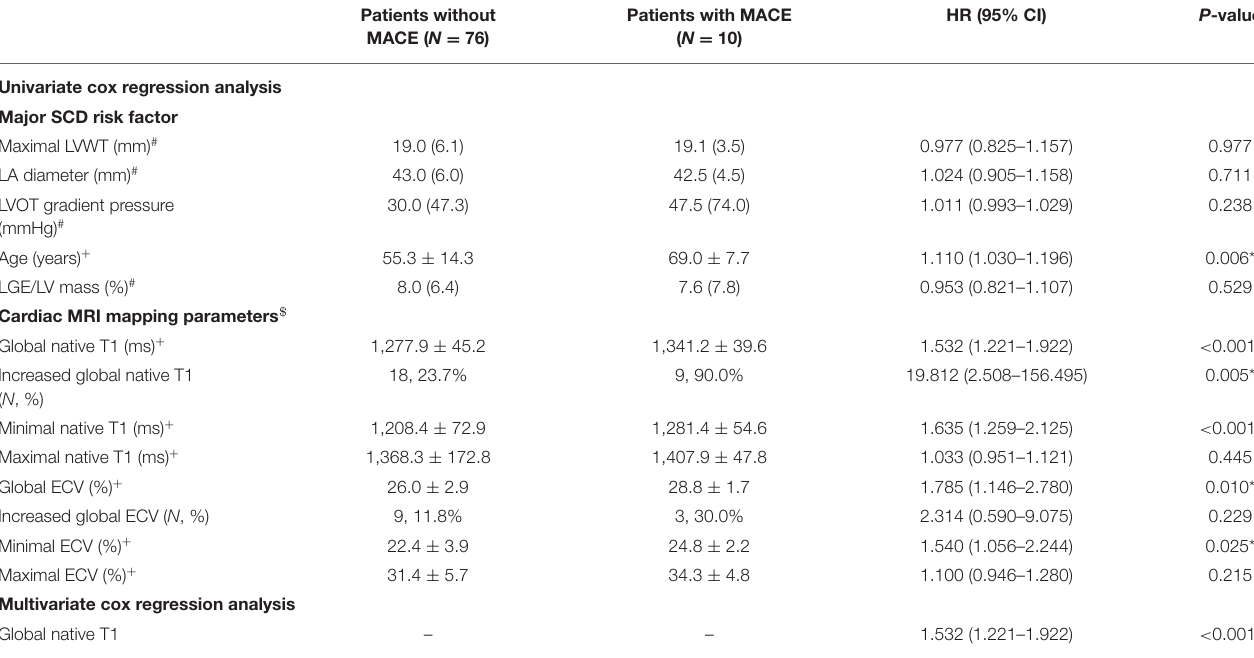
TABLE 6 | Univariate and multivariate Cox regression analysis of T1 mapping values for the prediction of MACE in subgroup 1.